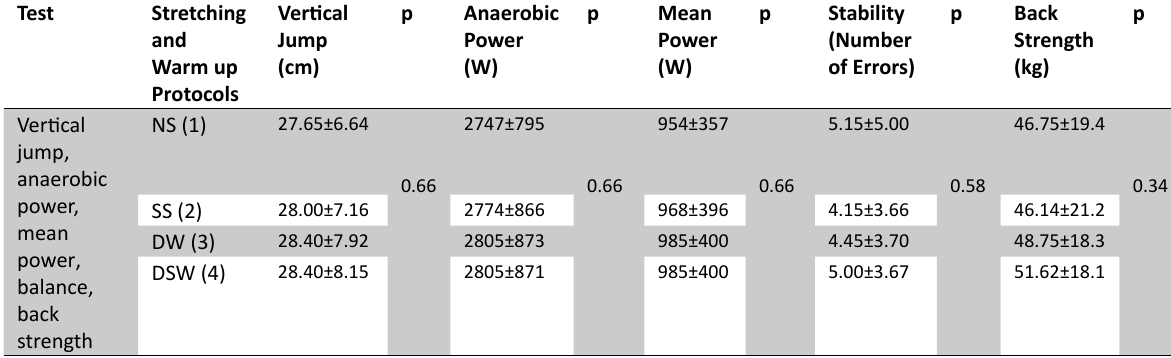
Table 4. Vertical jump, anaerobic power, mean power, balance and back